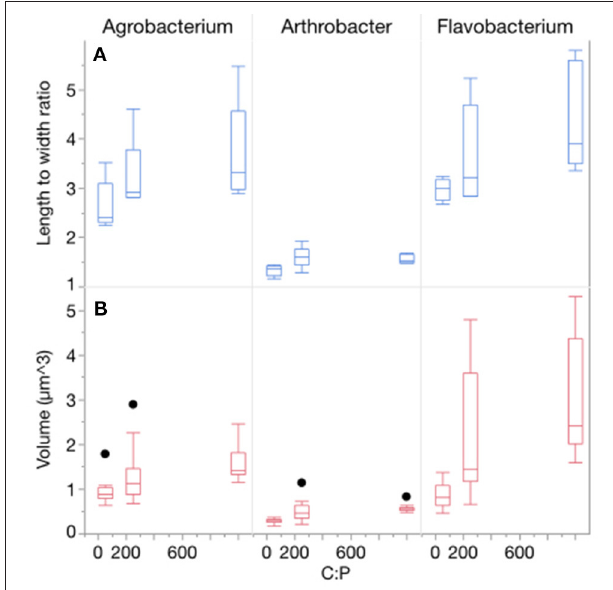
FIGURE 2 | (A) Changes in the morphology (length to width ratios) of each strain across C:P supply ratios. Bar depict the median with the 25th and 75th percentiles and error bars are the 95% confidence interval with outliers represented by points. (B) Changes in the biovolume ( µ m 3 ) of each strain across C:P supply